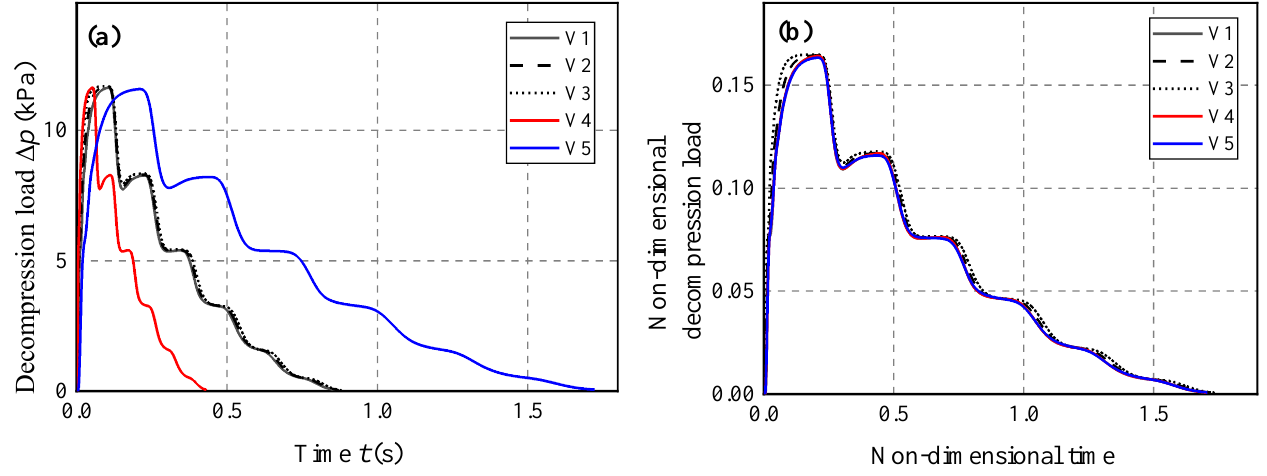
Figure 15. ( a ) Decompression load curves and ( b ) non-dimensional decompression load curves with varying cabin and cockpit volumes.